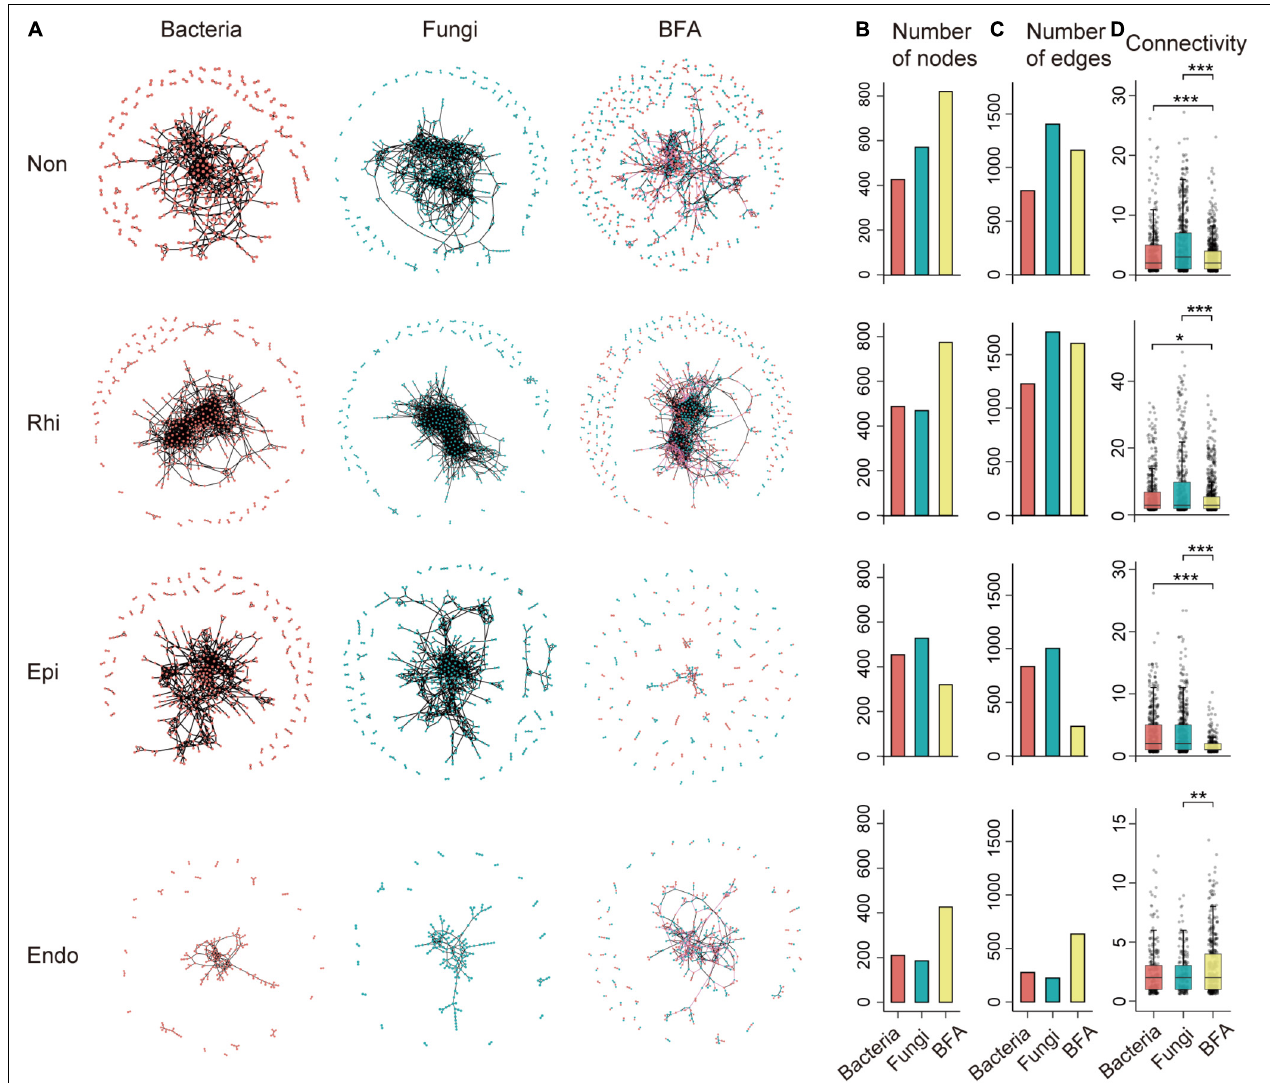
FIGURE 1 | The profile of intra-domain and inter-domain networks across the non-rhizosphere (Non), rhizosphere (Rhi), episphere (Epi), and endosphere (Endo) compartments. (A) A representation of bacterial, fungal and bacterial-fungal association (BFA) networks across four compartments in the soil-mangrove root system. Each node represents an operational taxonomic unit (OTU), and each edge represents a correlation between two OTUs. Red and blue nodes represent bacteria and fungi, respectively, whereas black and pink edges represent intra-domain and inter-domain interactions, respectively. (B,C) Show the total number of nodes and edges for each network. (D) The distribution of connectivity harbored by each node in bacterial, fungal and BFA networks. Connectivity is measured by degrees, which refers to the number of edges one node links with. Significance is tested with a two-sided Fisher’s exact test: * P < 0.05; ** P < 0.01; *** P <